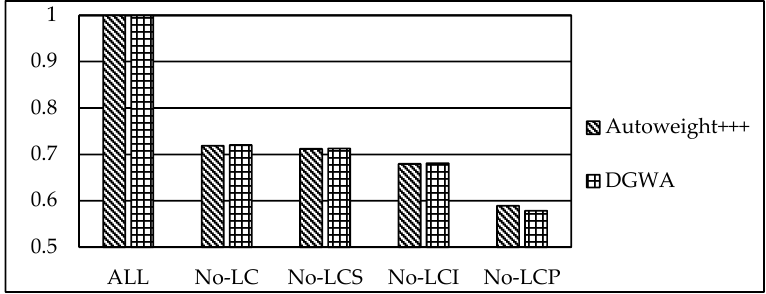
Figure 10. Comparison of methods Autoweight+++ and DGWA according to the results of recall measure for different groups of test cases within Benchmark biblio ontology track.